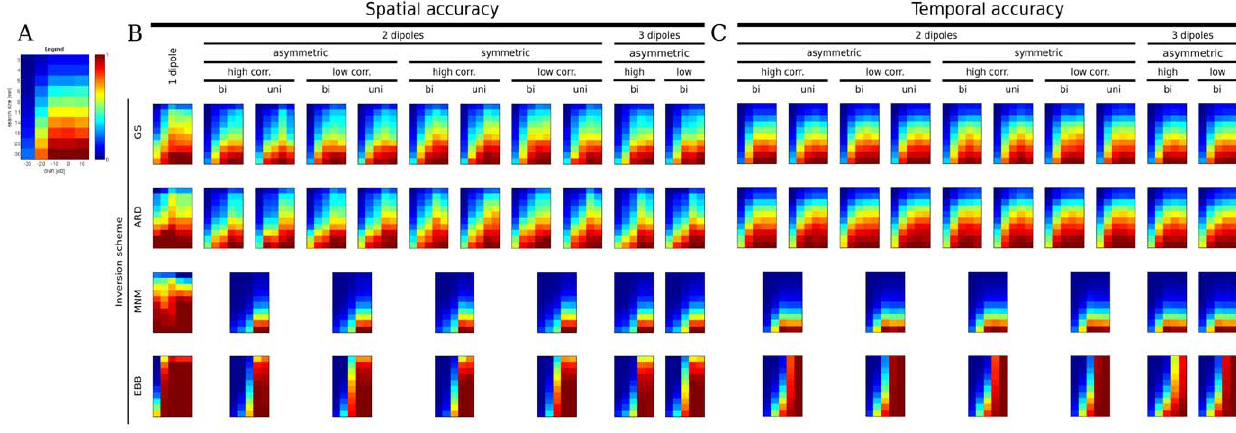
Figure 9. Summary of spatial (SAI) and temporal (TAI) accuracies of the four algorithms. A: Magnified example of a scale value grid for explanatory purposes. The color coded values represent the areas under the curve (AUC) pertaining to the spatial and temporal accuracy curves. AUC values are plotted as functions of SNR ( x axis, 2 30 dB to 10 dB) and search-size ( y axis, 3 mm to 30 mm, downward direction, logarithmic scale). B, C: Spatial (B) and temporal (C) accuracies were evaluated for 1, 2 and 3 dipoles. Different conditions were manipulated: (1) Symmetry of 2 sources (symmetric vs. asymmetric in the two hemispheres); (2) Correlation level between sources (high or low, for 2 and 3 sources); (3) Bilateral correlated source priors vs absence of them (only ARD and GS). ‘bi’ stands for correlated priors included. ‘uni’ stands for correlated priors omitted.